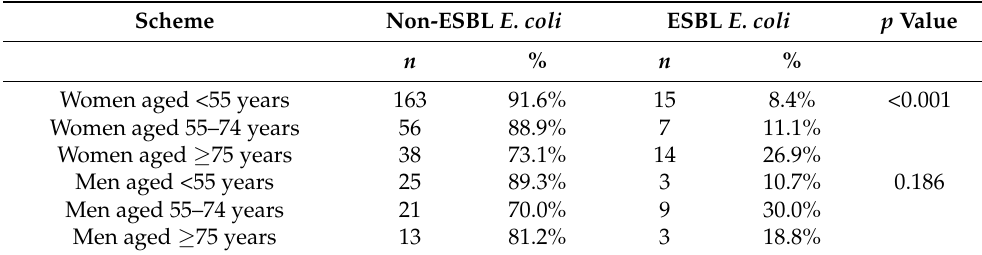
Table 3. Prevalence of extended-spectrum ß-lactamase (ESBL)-producing Escherichia coli ( E. coli ) in patients with acute pyelonephritis caused by E. coli , by sex and age.